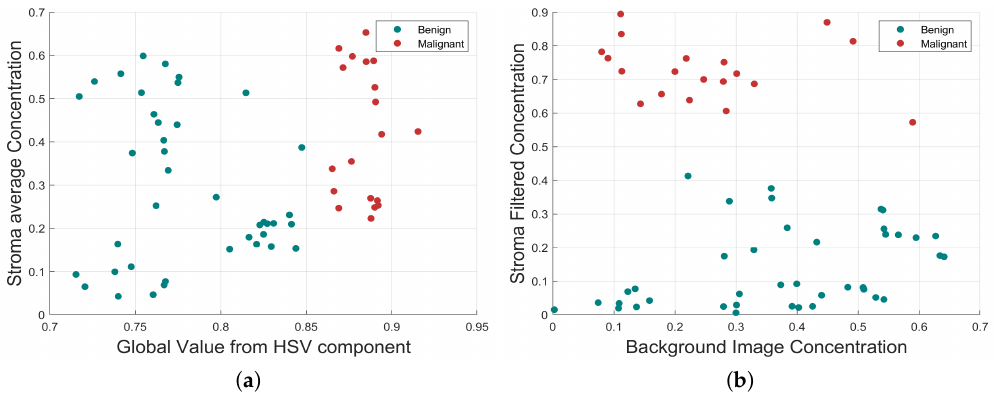
Figure 7. Morphological relationship between the four strongest correlated parameters. ( a ) Global value from HSV component and Stroma average Concentration. ( b ) Background Image Concentration and Stroma Filtered Concentration. In both cases, the benign and malignant cells are highlighted with different colours, which indicate a clear separation.